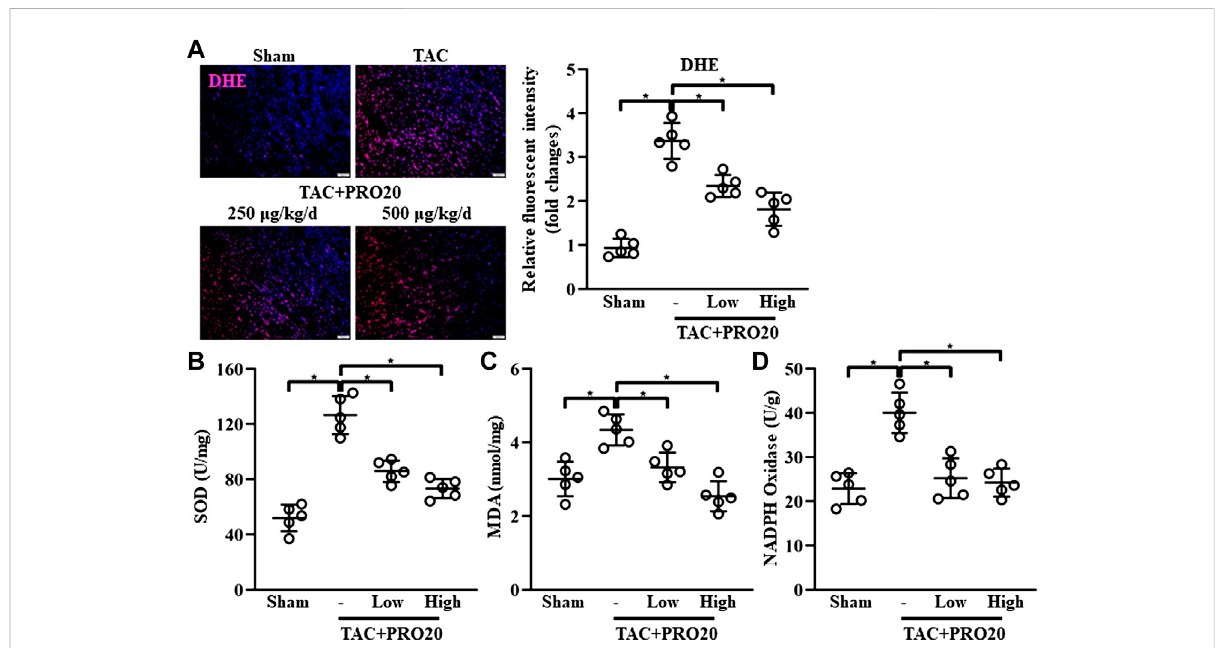
FIGURE 3 PRRdecoyinhibitor PRO20suppresses oxidative stressinTAC-inducedmice. (A) Representative immuno fl uorescentimages oftheproduction of reactive oxygen species assessed by dihydroethidium (DHE, stained in red) in hearts from TAC-induced mice with and without PRO20 treatment for 8 weeks. Nuclei were counterstained with DAPI (blue). (B – D) The content of SOD, MDA and NADPH oxidase in hearts from TAC-induced mice with and without PRO20 treatment for 8 weeks p p -value < 0.05. n = 5 per group. Data are expressed as mean ±